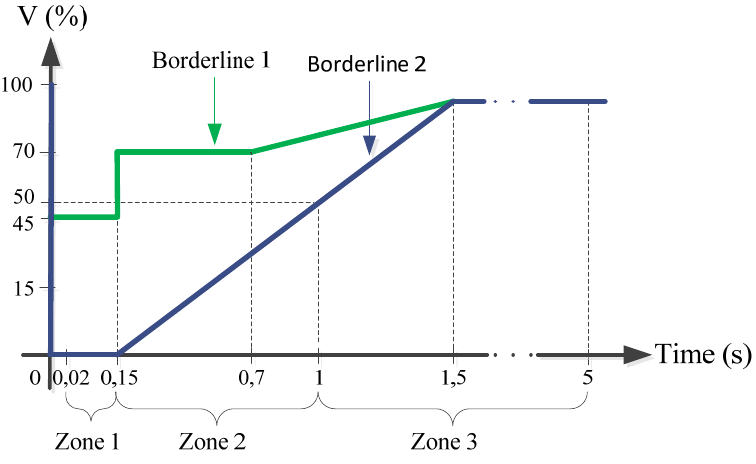
Figure 2. LVRT profile in the German grid code.